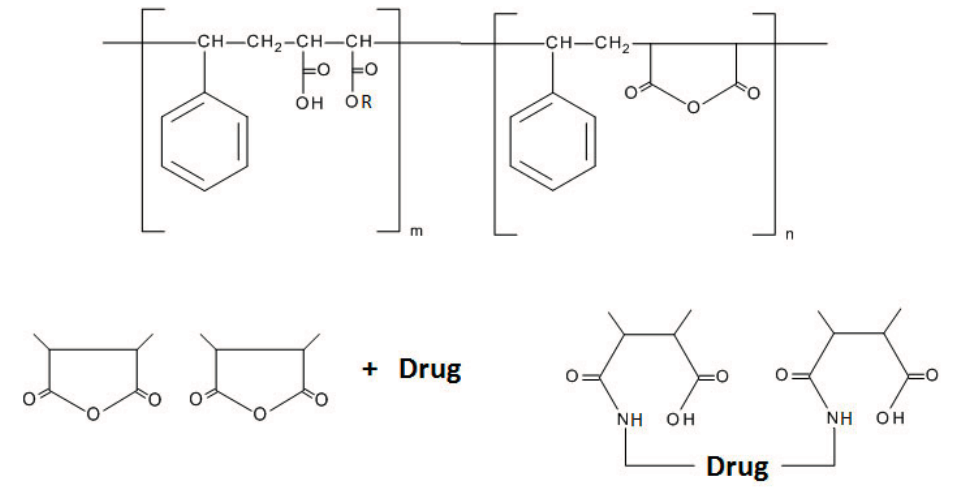
Figure 4. Structure of Poly (styrene-co-maleic acid/anhydride) (SMA) and its drug conjugation [61].